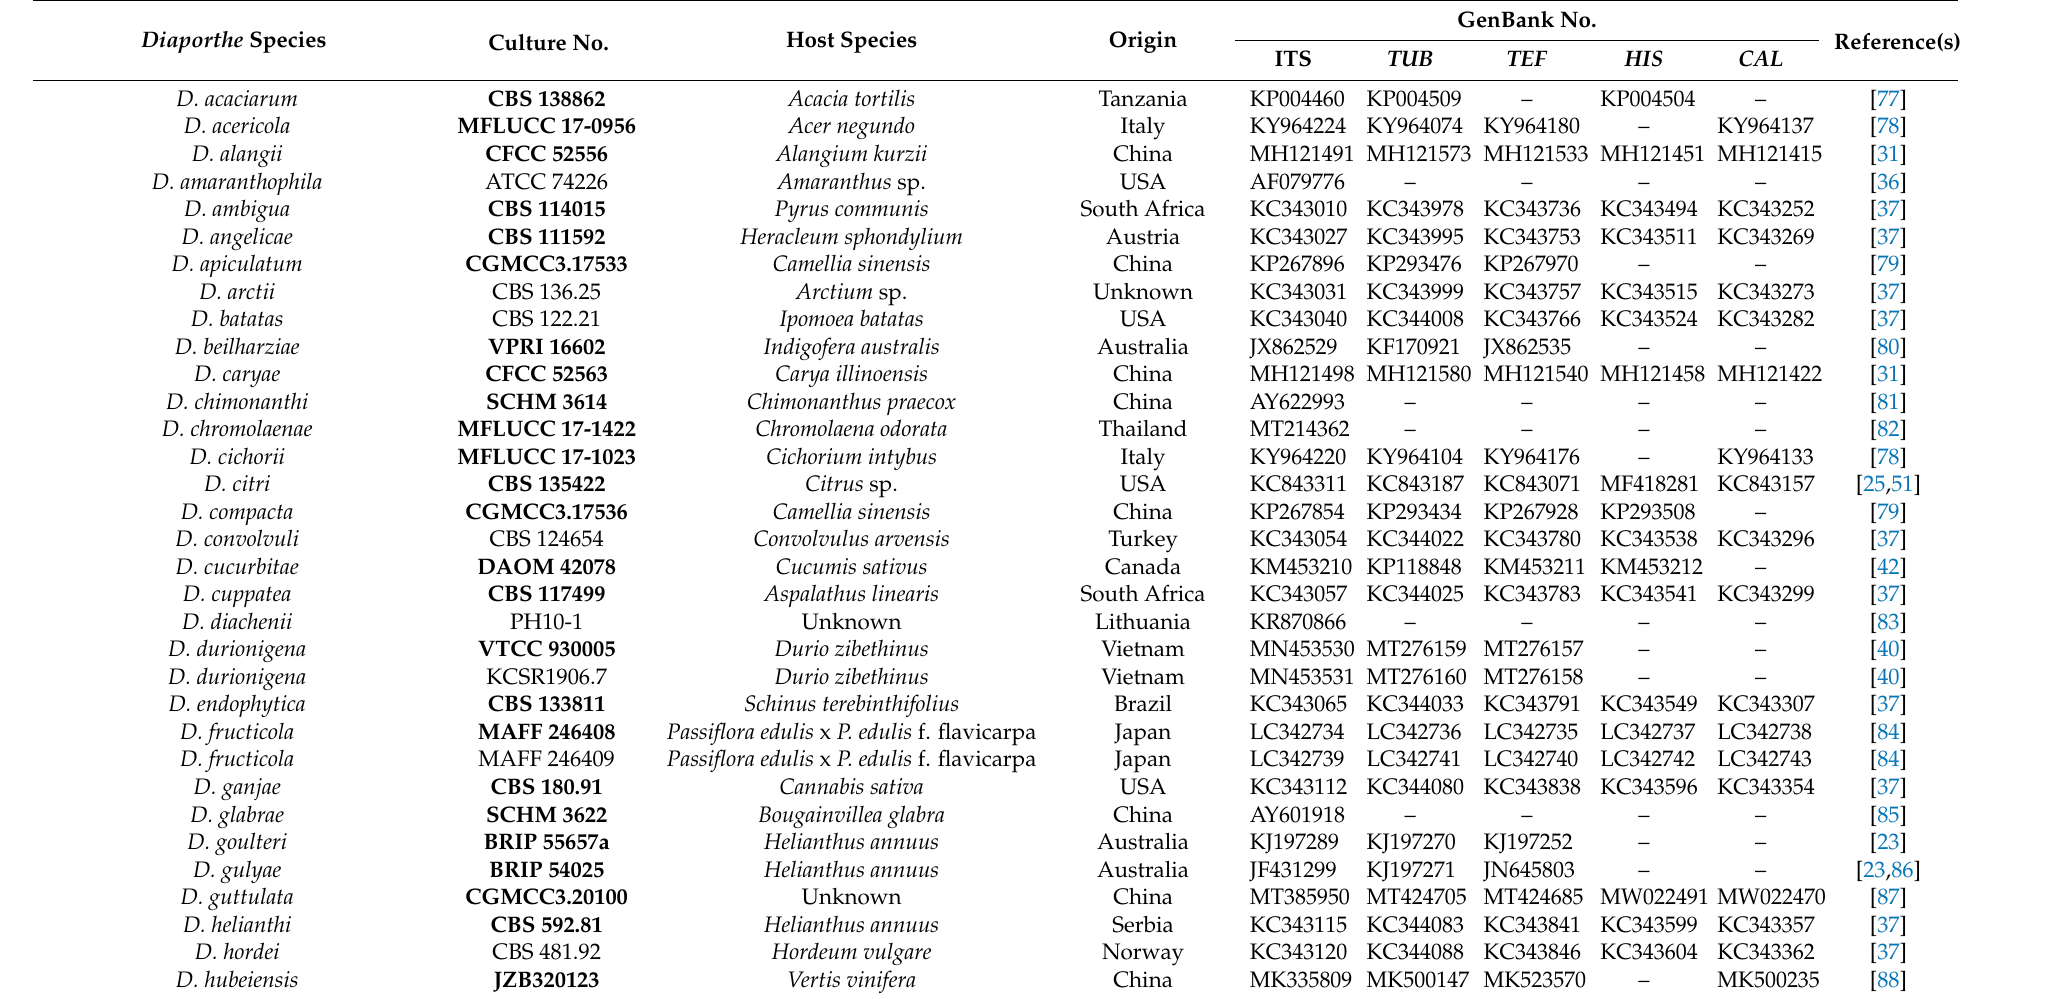
Table 1. GenBank accession numbers of isolates used in this